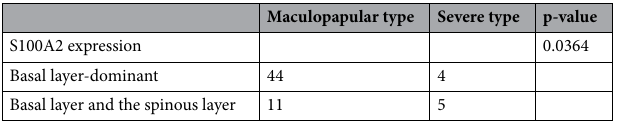
Table 2. Comparison between maculopapular type and severe type drug